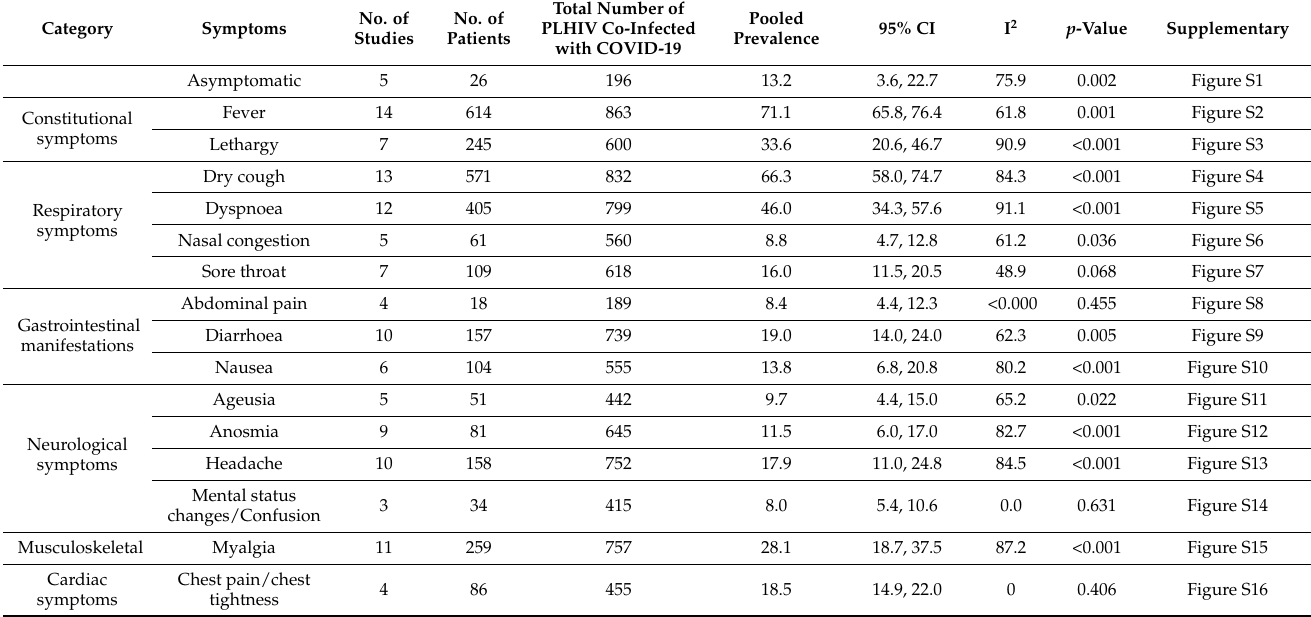
Table 2. Pooled prevalence and 95% confidence interval (CI) of COVID-19 symptoms.